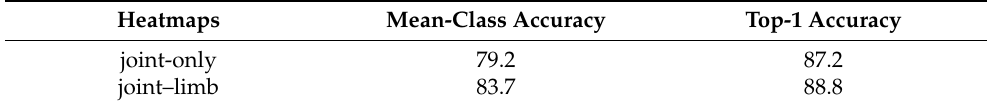
Table 4. The different heatmaps for skeleton-based human action recognition. We report the mean- class and Top-1 accuracy on the FineGym99 dataset. Units are in